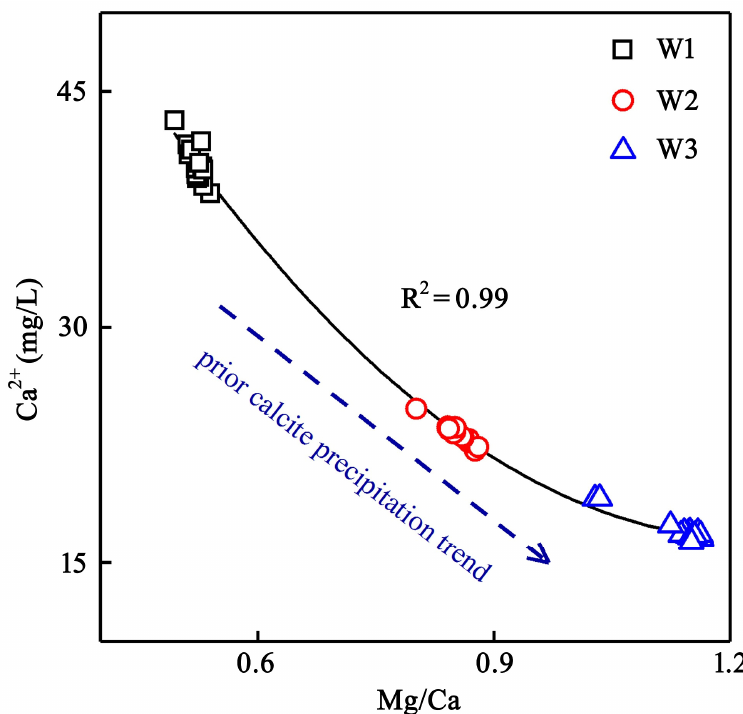
Figure 7. Correlation between Ca 2+ and Mg/Ca at the three selected cave drip water